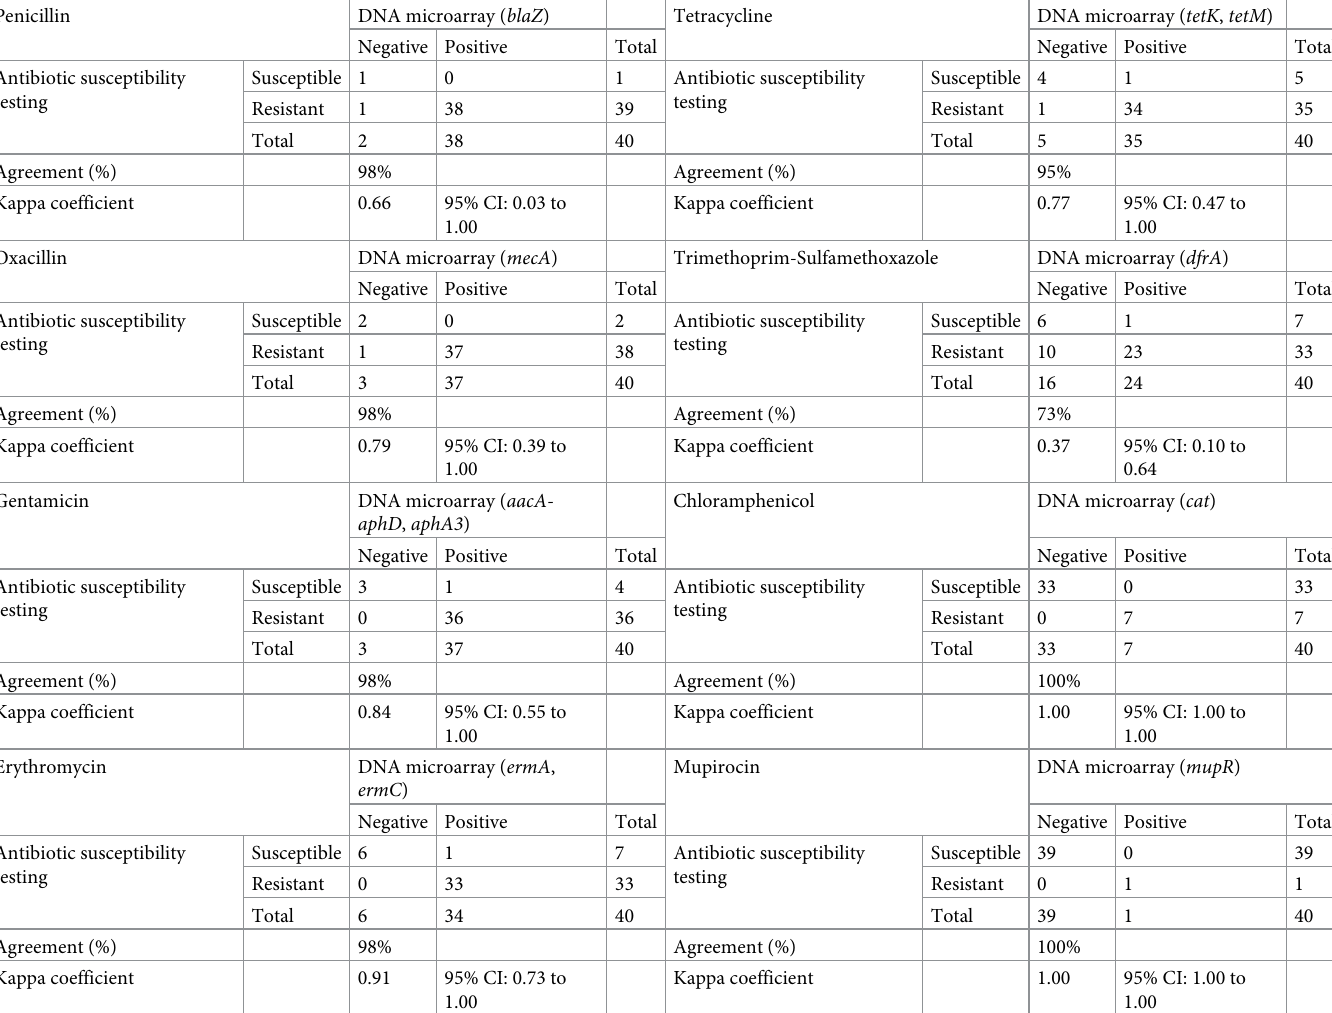
Table 1. Percentage and level of agreement between antibiotic susceptibility testing (AST) and DNA microarray with S . aureus isolates from Nigeria and South